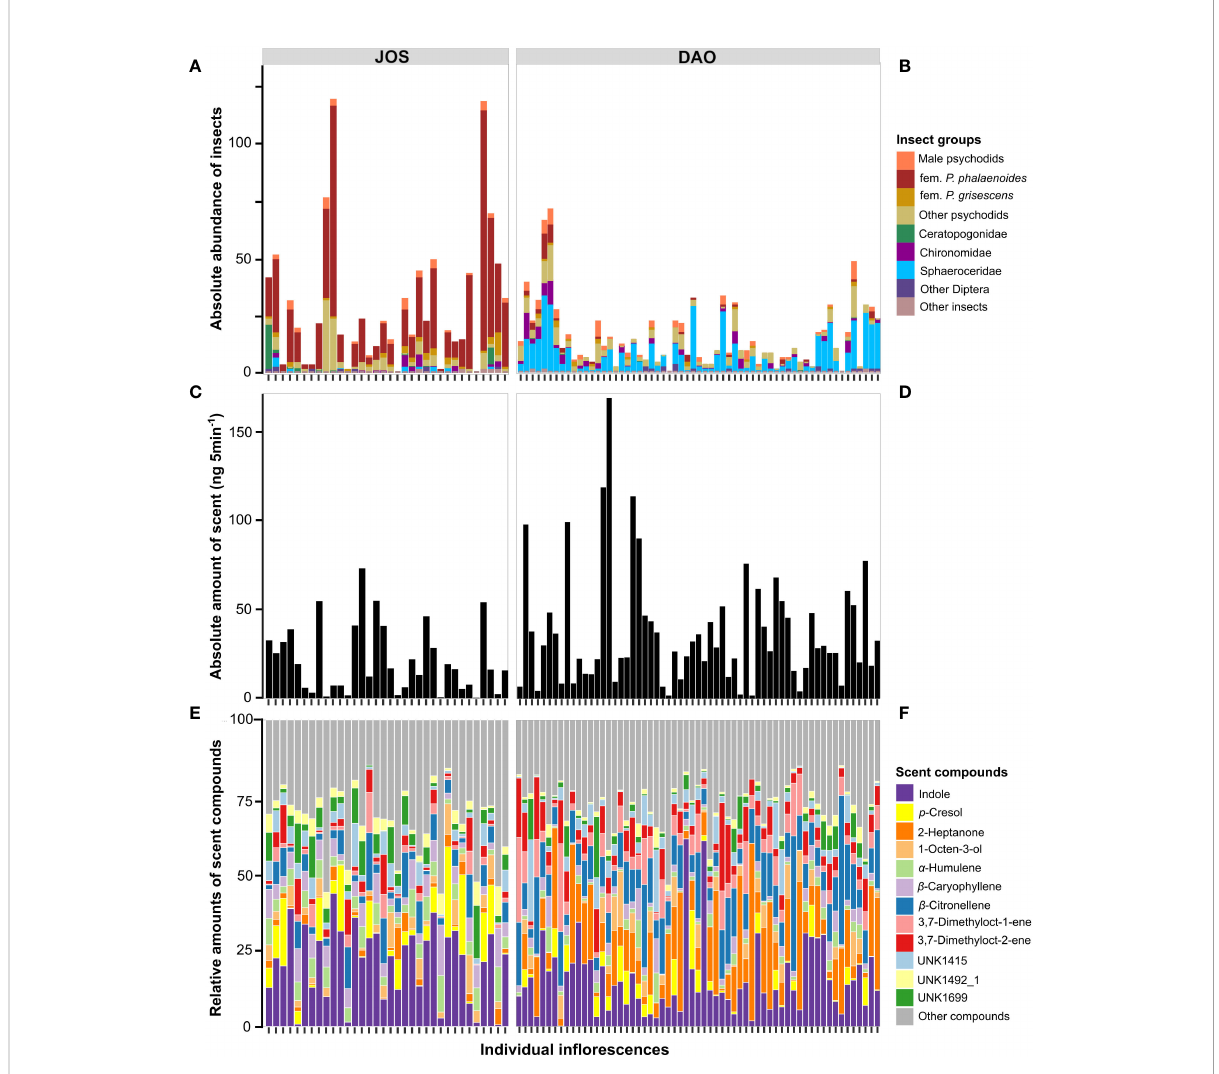
FIGURE 1 Inter-individual variation in the two studied populations of Arum maculatum from northern-central Austria (JOS; Salzburg; N = 34; A, C, E ) and northern Italy (DAO; Daone, Trentino; N = 61; B, D, F ) with respect to (A, B) absolute abundance of fl oral visitors trapped per fl oral chamber, (C, D) total amount of scent emitted, and (E, F) relative amounts of scent compounds. fem., female; P. , Psychoda ; UNK, unknown, with the number following UNK being the Kovats' retention index of the